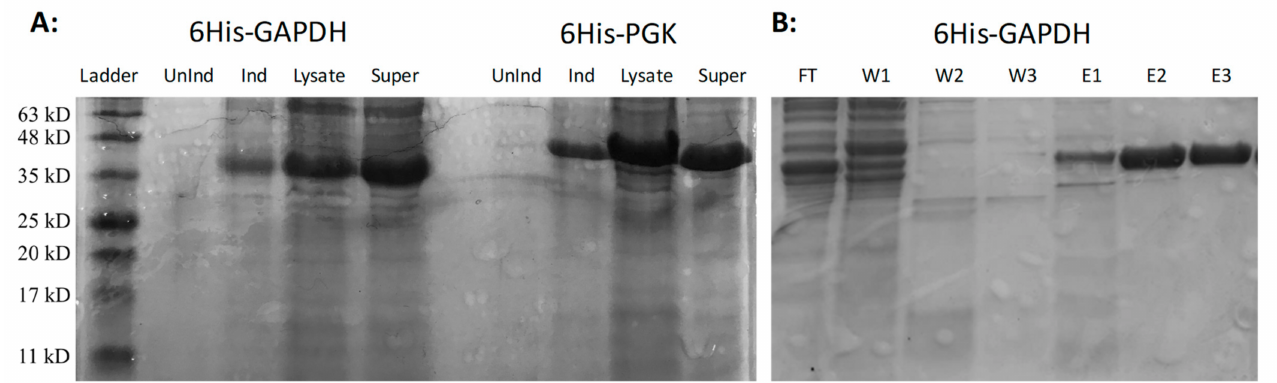
Figure 4. Expression and purification of fusion proteins. ( A ): 15% SDS-PAGE gel of purified 6His- GAPDH (left) and 6His-PGK (right). From left to right for each protein: uninduced cells, cells induced with 1 mM IPTG, sonicated cell lysate and the supernatant of centrifugated cell lysate. GAPDH and PGK proteins are the dominant bands at around 40 kDa and 46 kDa, respectively. ( B ): Ni 2+ -NTA purification of 6His-GAPDH. From left to right: Flow-through of unbound protein (FT), washes 1–3 (W1–W3) and elutions 1–3